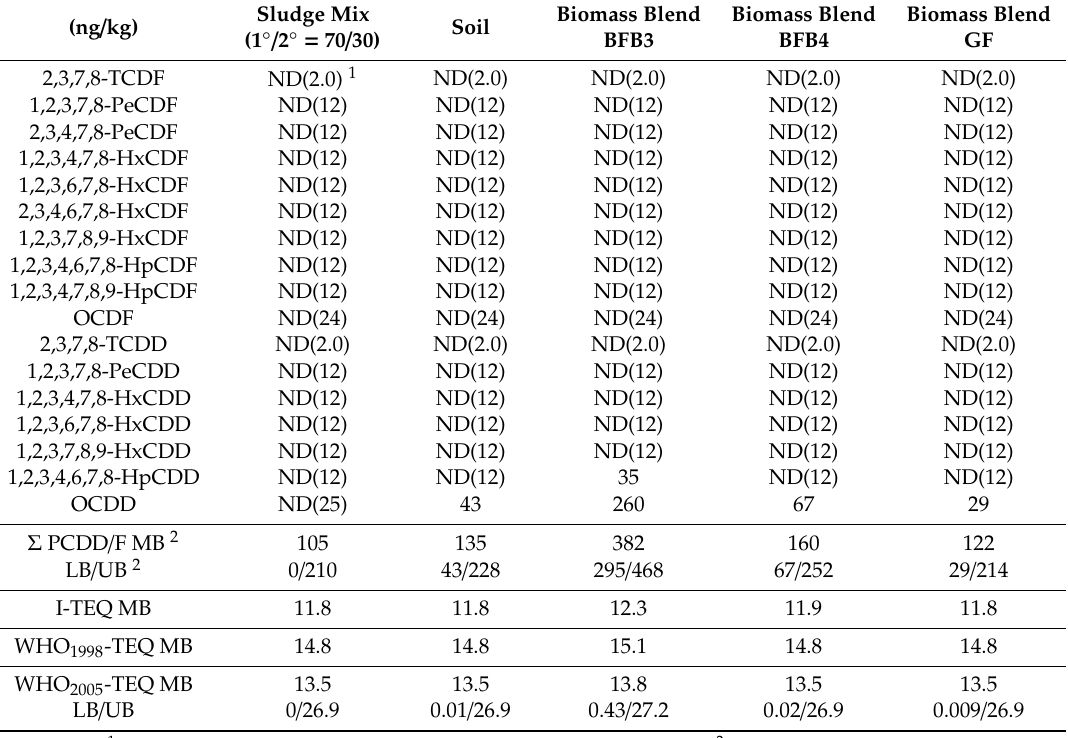
Table 5. PCDD / Fs and TEQs of biomass blends, sludge and soil, in dry